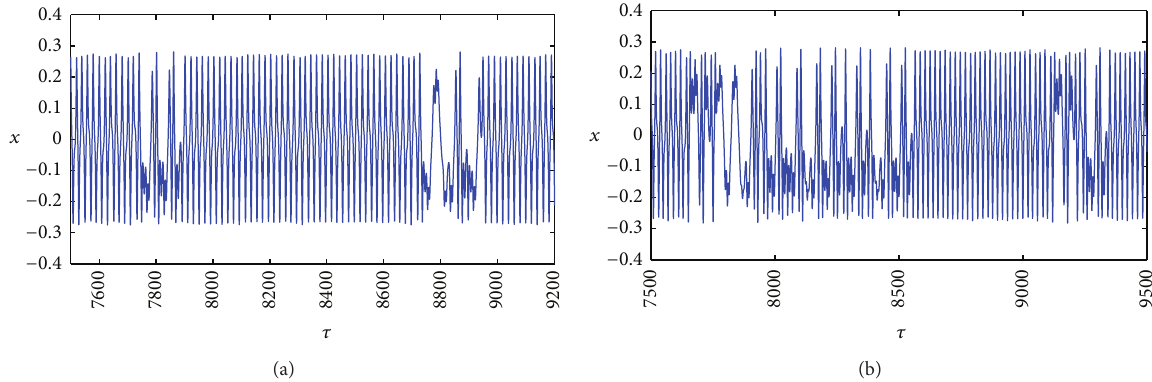
Figure 9: Numerically obtained time series of the vibration response for 𝜔 𝑒 = 12 Hz and (a) 𝑍 𝑒 = 2.12𝑔 and (b) 𝑍 𝑒 = 2.13𝑔 .